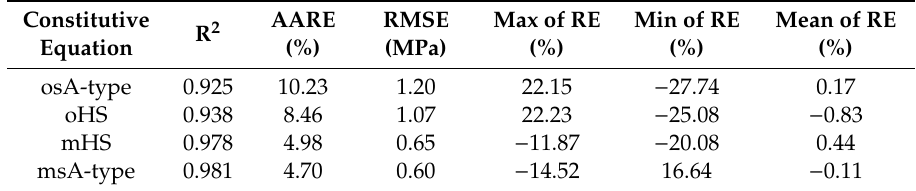
Table 7. R 2 , AARE, RMSE and relative errors (RE) of the original strain-compensated Arrhenius-type (osA-type) equation, the modified strain-compensated Arrhenius-type (msA-type) equation, the original Hensel–Spittel (oHS) equation and the modified Hensel–Spittel (mHS) equation. AARE RMSE Max of RE Min of RE Mean of RE Constitutive R 2 (%) (MPa) (%) (%) (%) Equation osA-type 0.925 10.23 1.20 22.15 − 27.74 0.17 oHS 0.938 8.46 1.07 22.23 − 25.08 − 0.83 mHS 0.978 4.98 0.65 − 11.87 msA-type 0.981 4.70 0.60 −